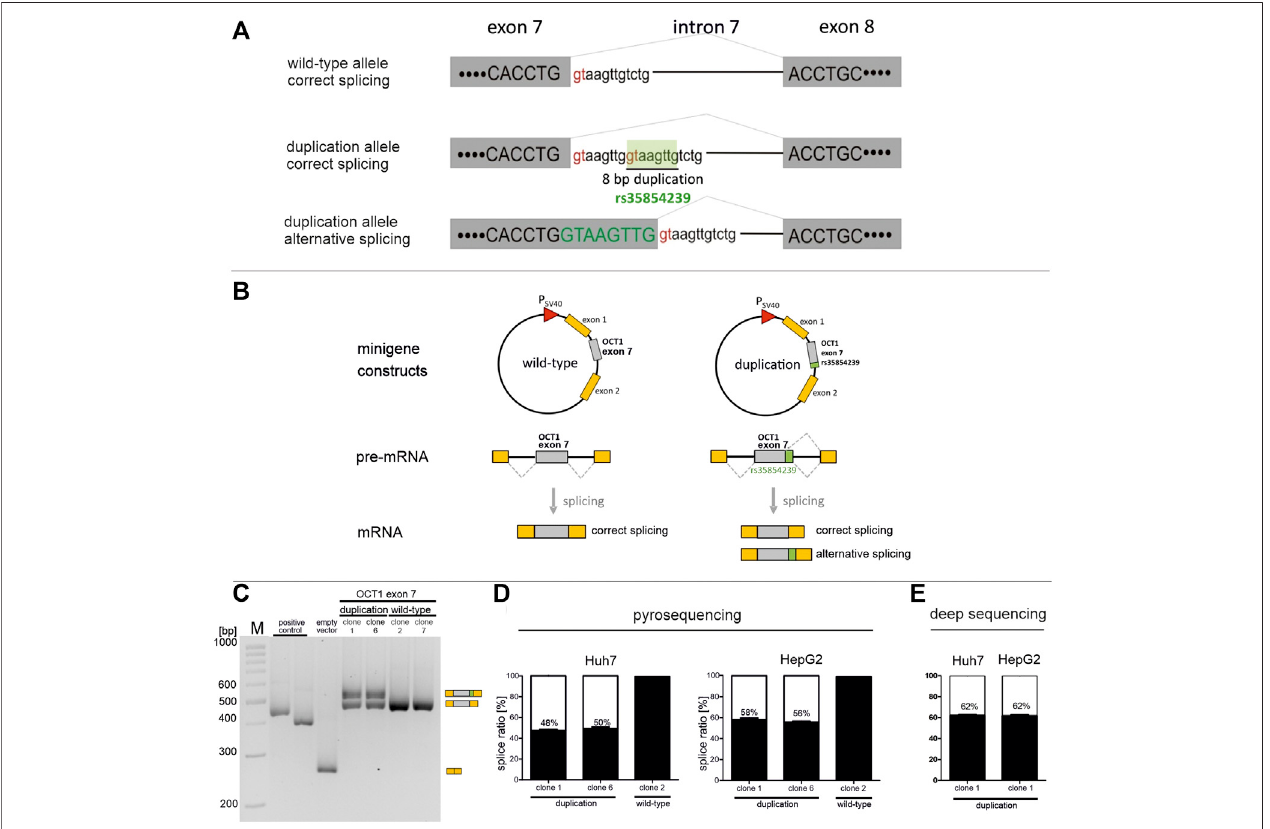
FIGURE1| Effects ofrs35854239on SLC22A1 exon7 minigenesplicingin Huh7 and HepG2 (A) Splicingat the exon7-intron 7junction. Splice donor siteswithin theintronicsequenceareshowninred.The8bpinsertion/deletionvariant rs35854239carriesasecondsplice donorsitethatisproposedtobesplicedalternatively. (B) RepresentationofthepSPL3bsplicingvectorconsistingoftwoexonsoftherabbit β -globulingeneundercontroloftheSV40promoter(the “ minigene ” ).SLC22A1exon7 and its fl anking intronic regions with or without rs35854239 (referred to as duplication or wild-type, respectively) were cloned between both exons of the rabbit β -globulin gene. Minigene constructs were transiently transfected into Huh7 and HepG2 cells, and mRNA was isolated 48 h after transfection. As positive control we usedtheCYP2C19*2variant,forwhichalternativesplicingisknown,(Moraisetal.,1994). (C,D) CorrectlyandalternativelysplicedOCT1transcriptswereshown (C) and quanti fi edusingpyrosequencing (D) ,ordeepRNA-sequencing (E) .Percentageswithinboxesrepresentrelativevaluesofcorrectlysplicedminigenetranscripts.Dataare shown as mean and standard errors of the mean of at least three independent